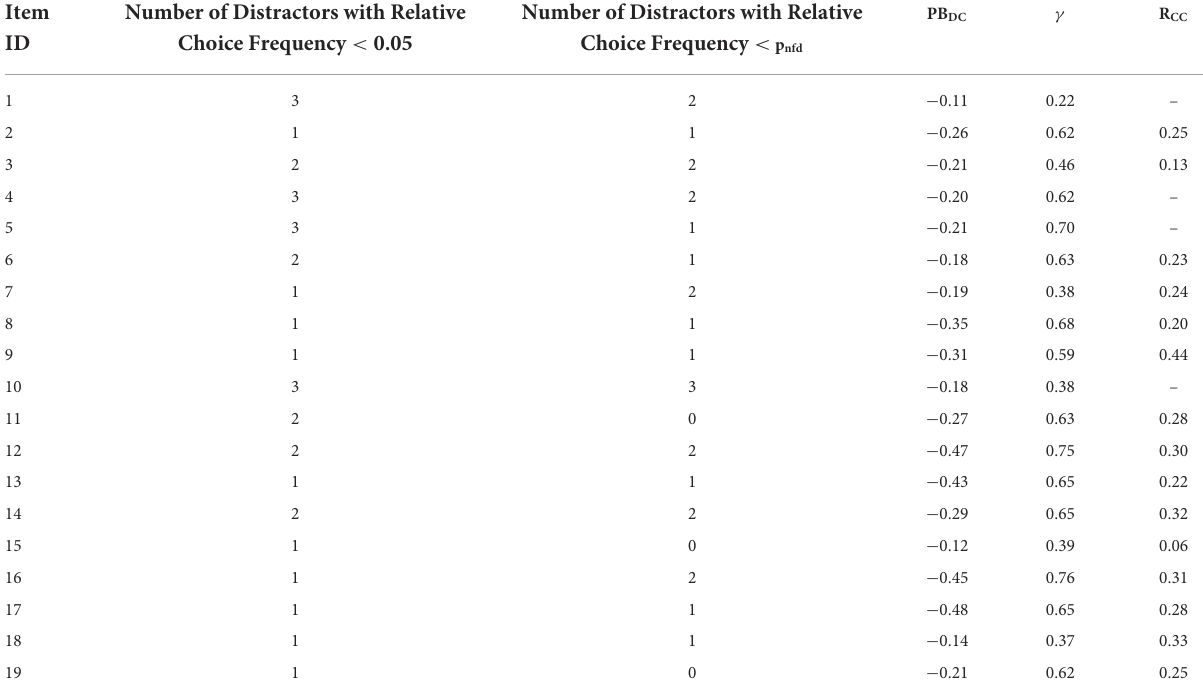
TABLE 2 Distractor analyses